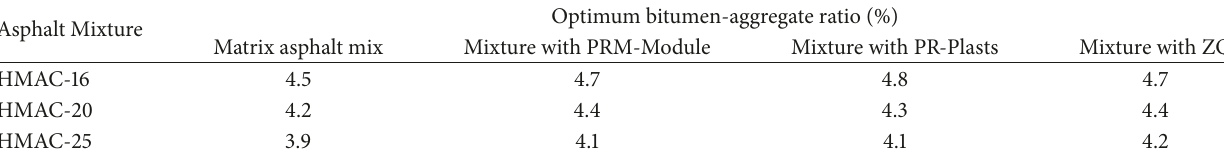
Table 3: Optimum bitumen-aggregate ratio of mixtures.